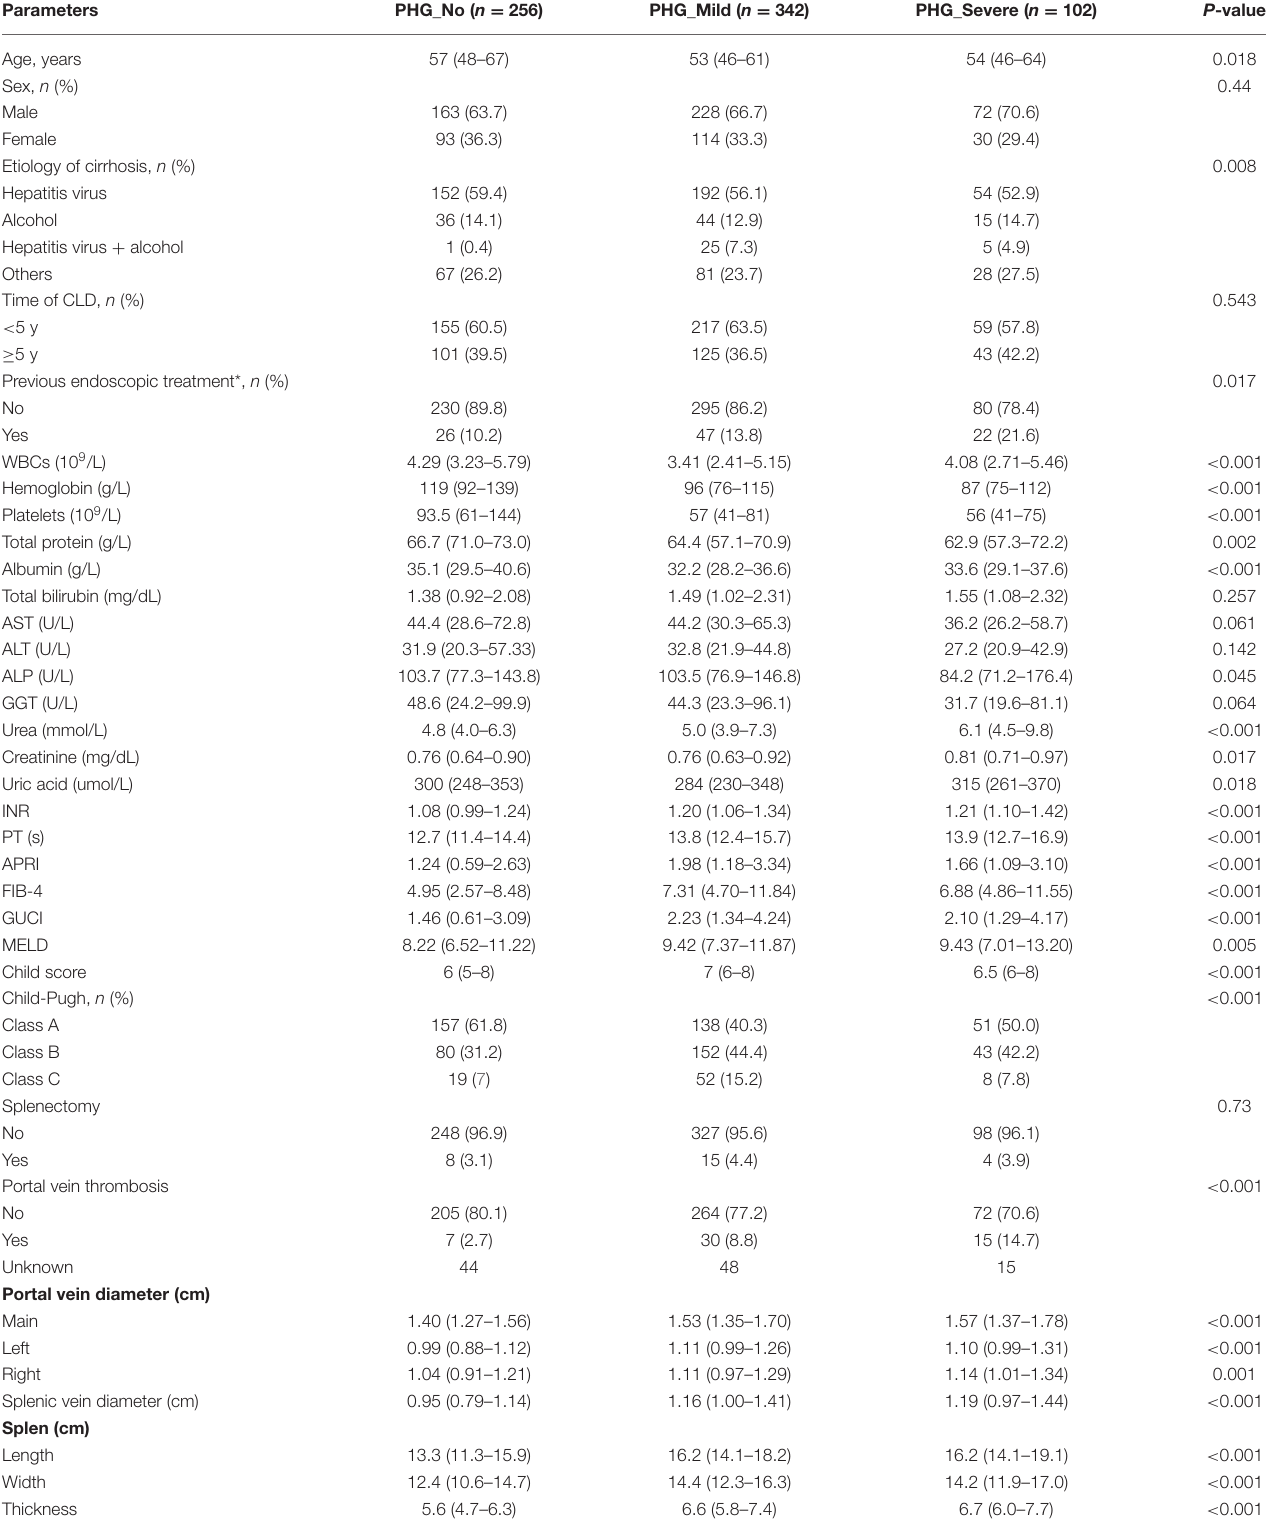
TABLE 1 | The clinicopathological characteristics of patients enrolled in this study.